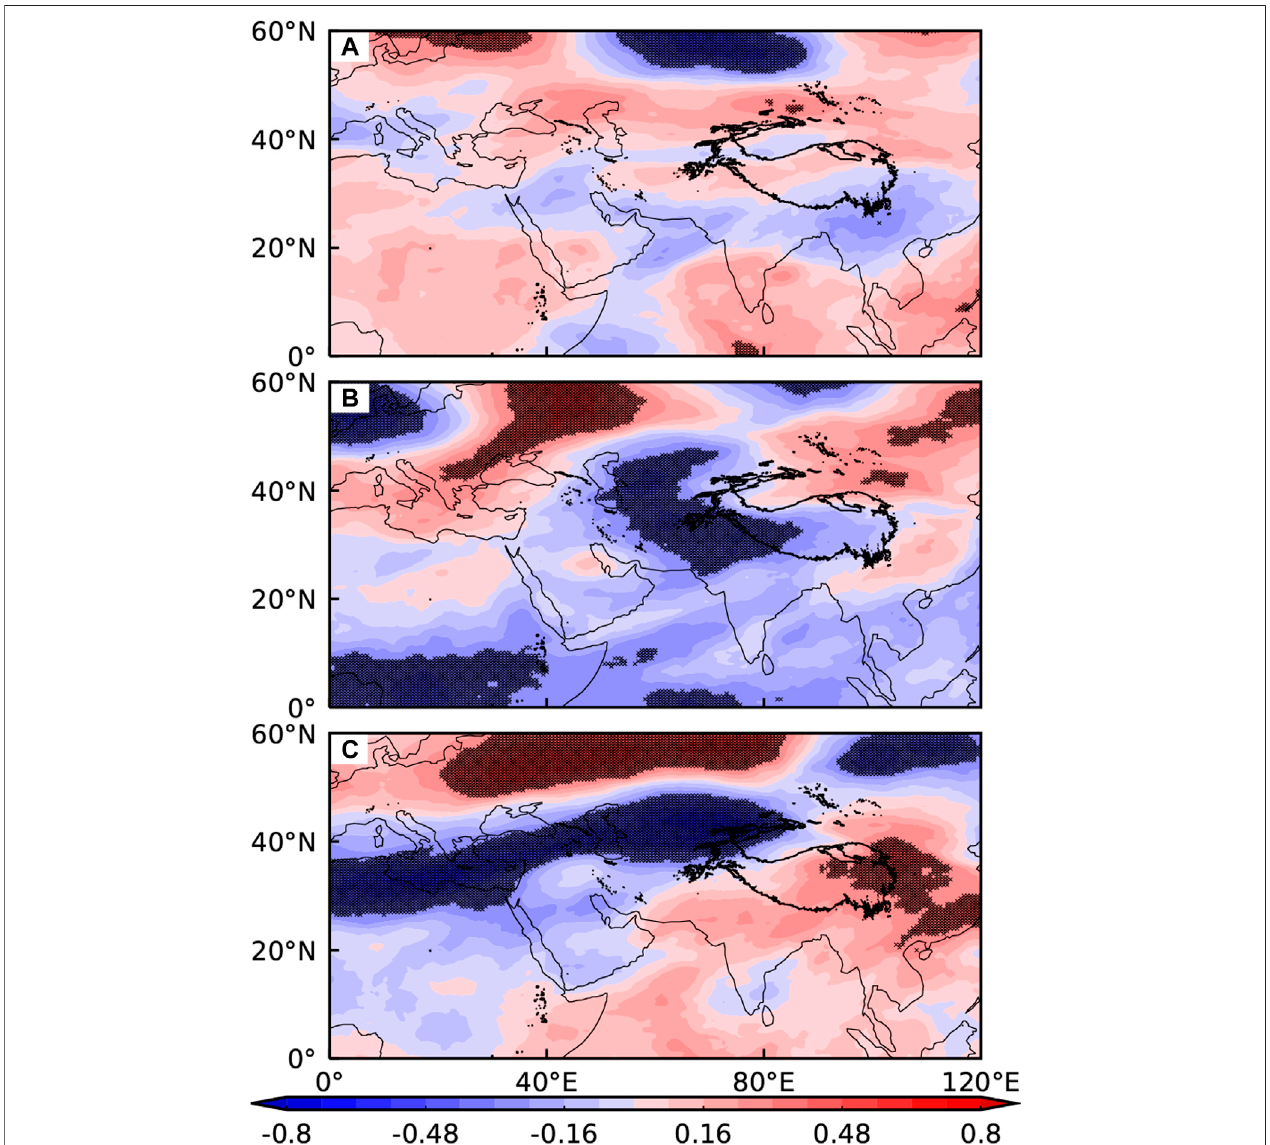
FIGURE 4 | Regression analysis of tropopause heights (shading, unit: hPa) against the time series of (A) EOF1, (B) EOF2, and (C) EOF3. Black dots represent the regressed tropopause signi fi cant at the 95% con fi dence level.